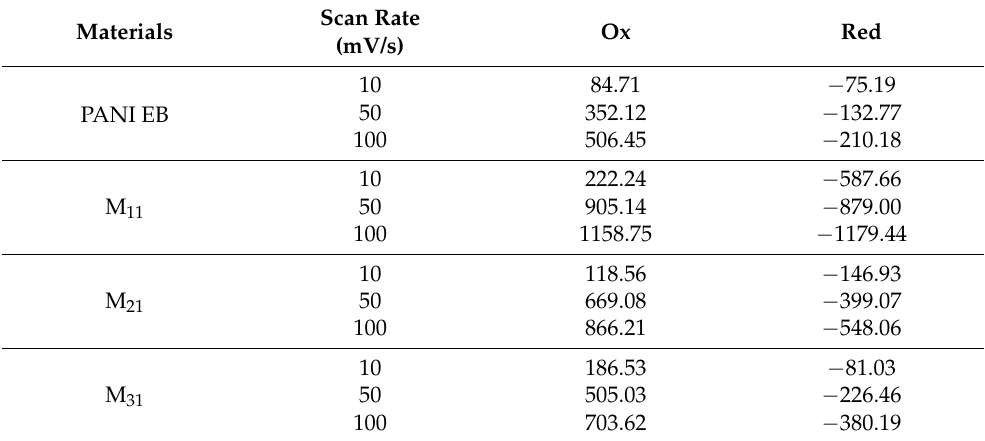
Table 8. Redox parameters from cyclic voltammogram peaks of PANI and PANI/starch biocomposites.